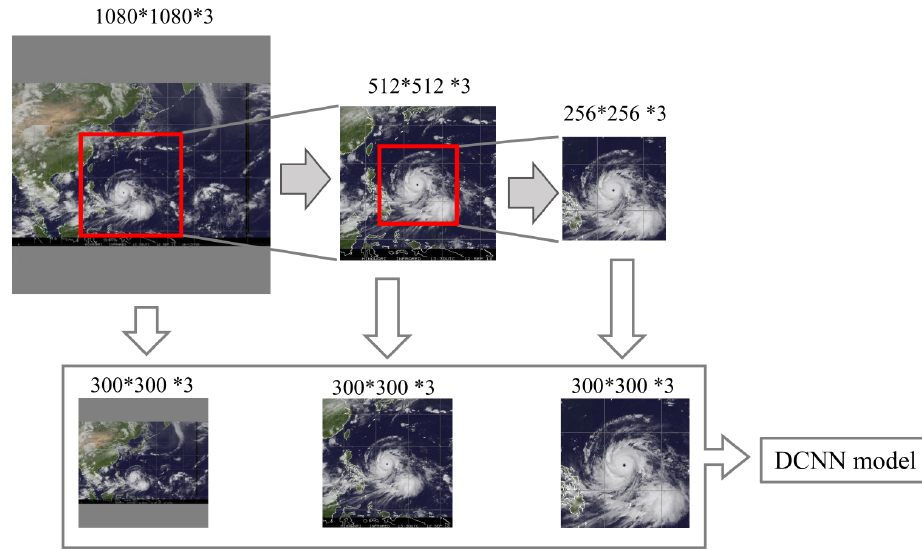
Figure 13. Flowchart for the realization of image pyramid of a TC image.